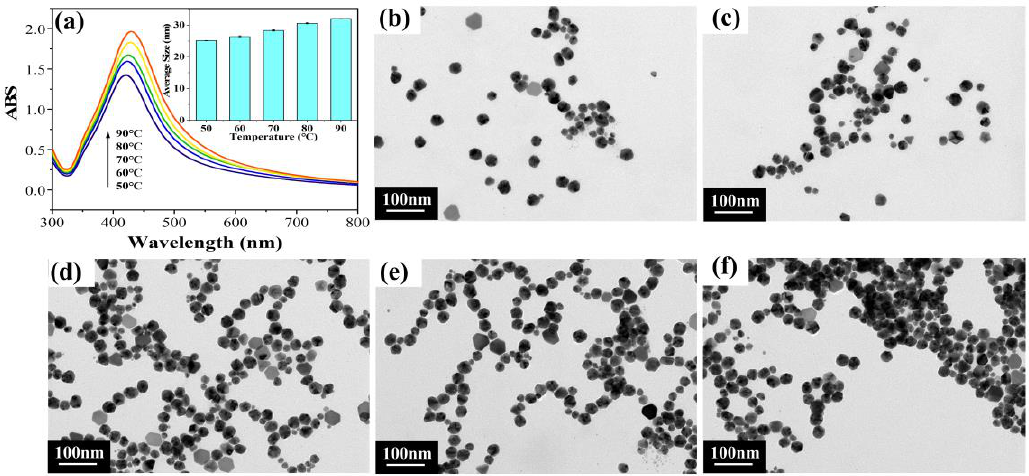
Figure 3. Results for different reaction temperatures: ( a ) UV-vis spectra and (inset) average size histogram; ( b – f ) TEM images for reaction temperatures of 50–90 ◦ C,